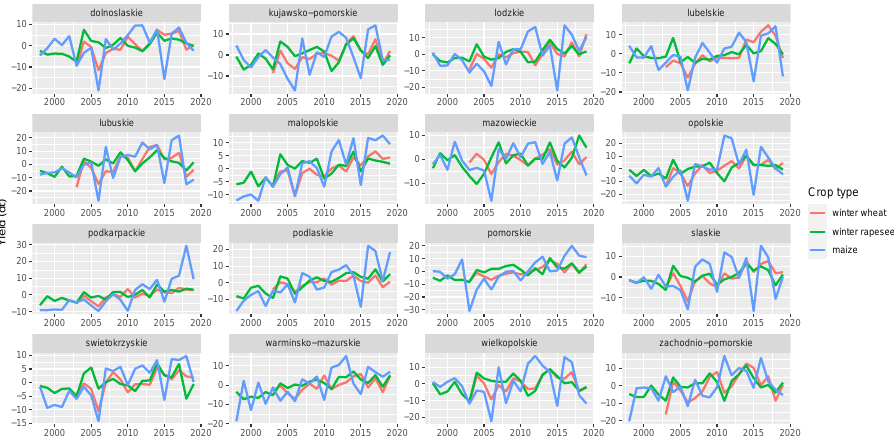
Figure 4. Temporal yield residuals from Theil–Sen monotonic trend used as a response variable in crop yield forecasting for NUTS-2. Please mind different limits of